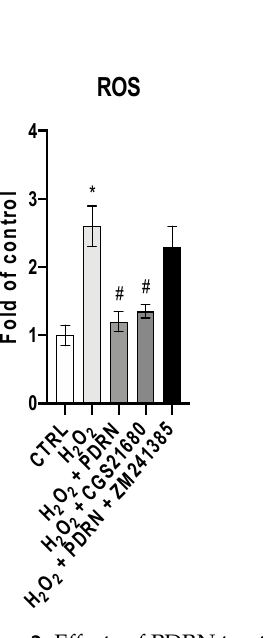
Figure 2. Effects of PDRN treatment on ROS production ( A ) and MDA generation ( B ) in IHCE cells. The values are expressed as the means ± SD. * p < 0.0001 vs. CTRL; # p < 0.0001 vs. H 2 O 2 .